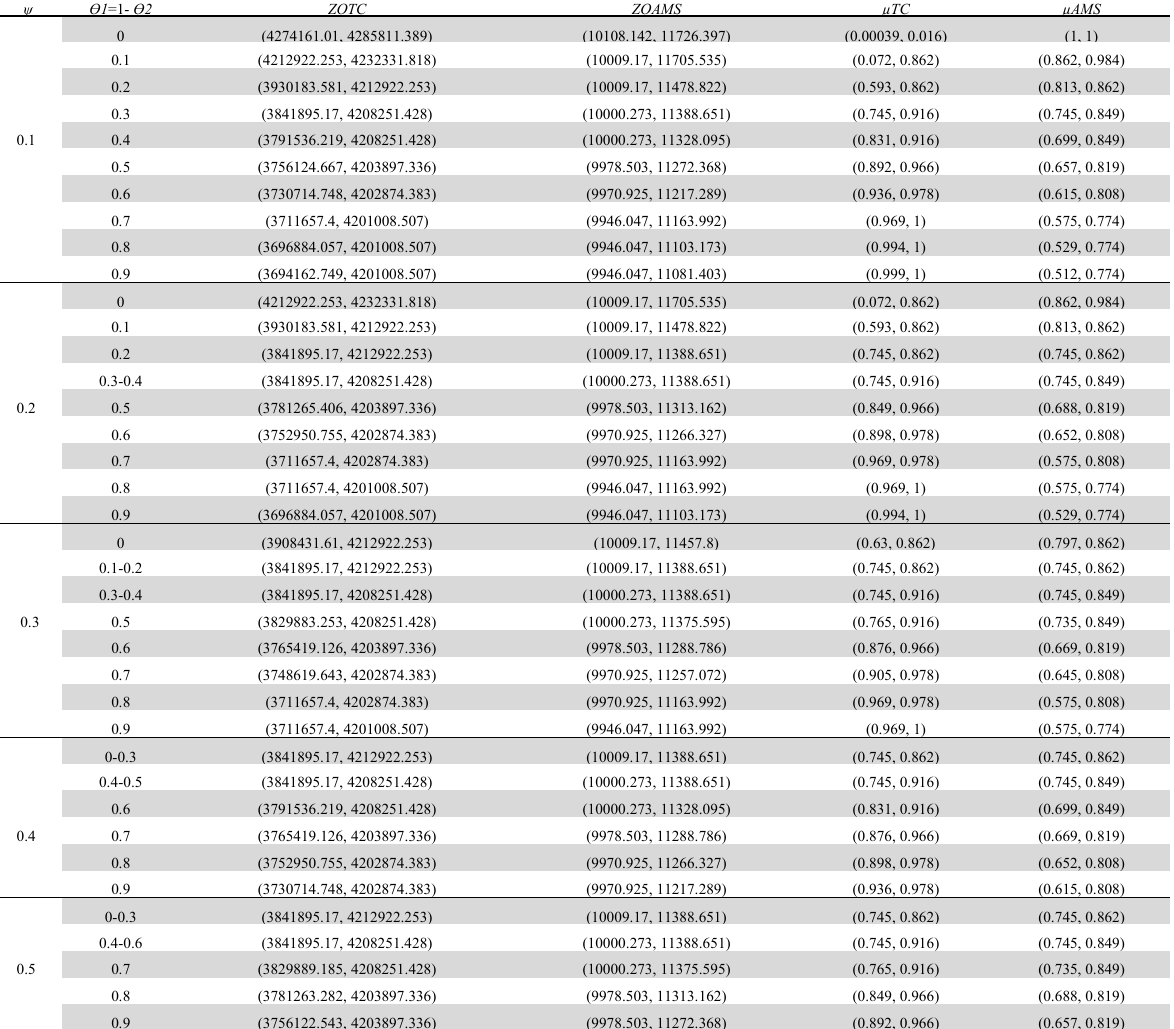
Sensitivity analysis on both values of ψ and Ɵ 1 =1- Ɵ 2 under λ =0.6 and τ